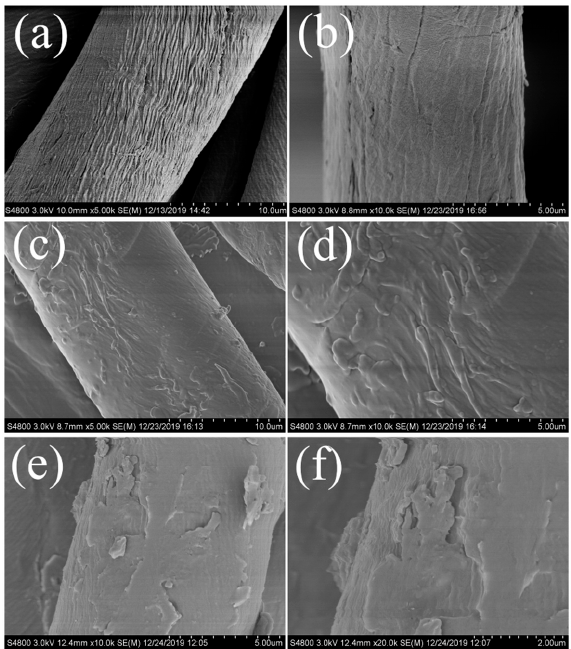
Figure 3. SEM images of the ( a , b ) original fabric, ( c , d ) fabric-SH, and ( e , f ) superhydrophobic fabric.